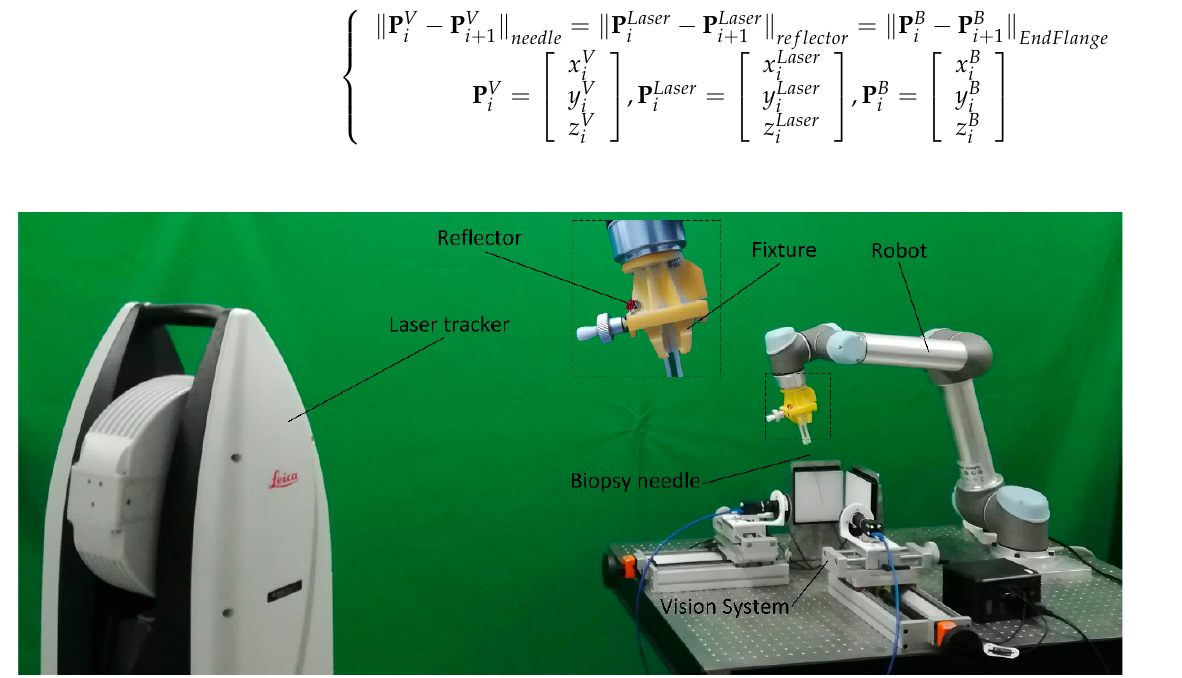
Figure 9. Accuracy testing experiment.